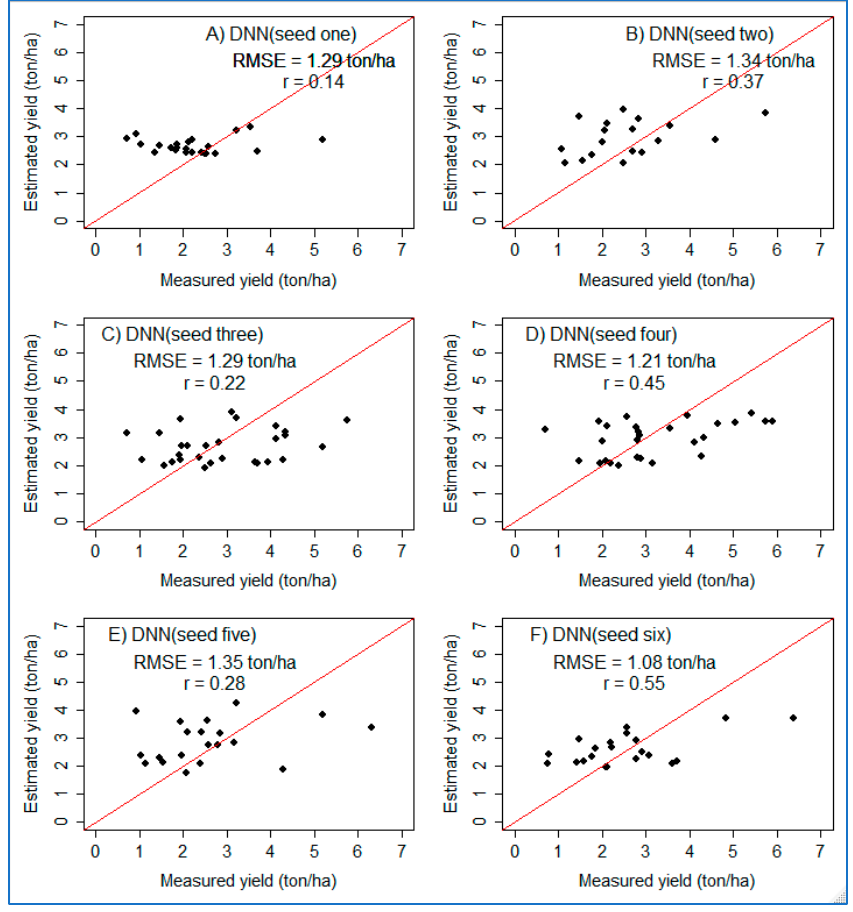
Figure 11. Scatter plots showing the performance of DNN with three hidden layers on the test dataset for six randomly selected seeds. ( A – F ) refer to six plots prepared using six randomly generated numbers (seeds).